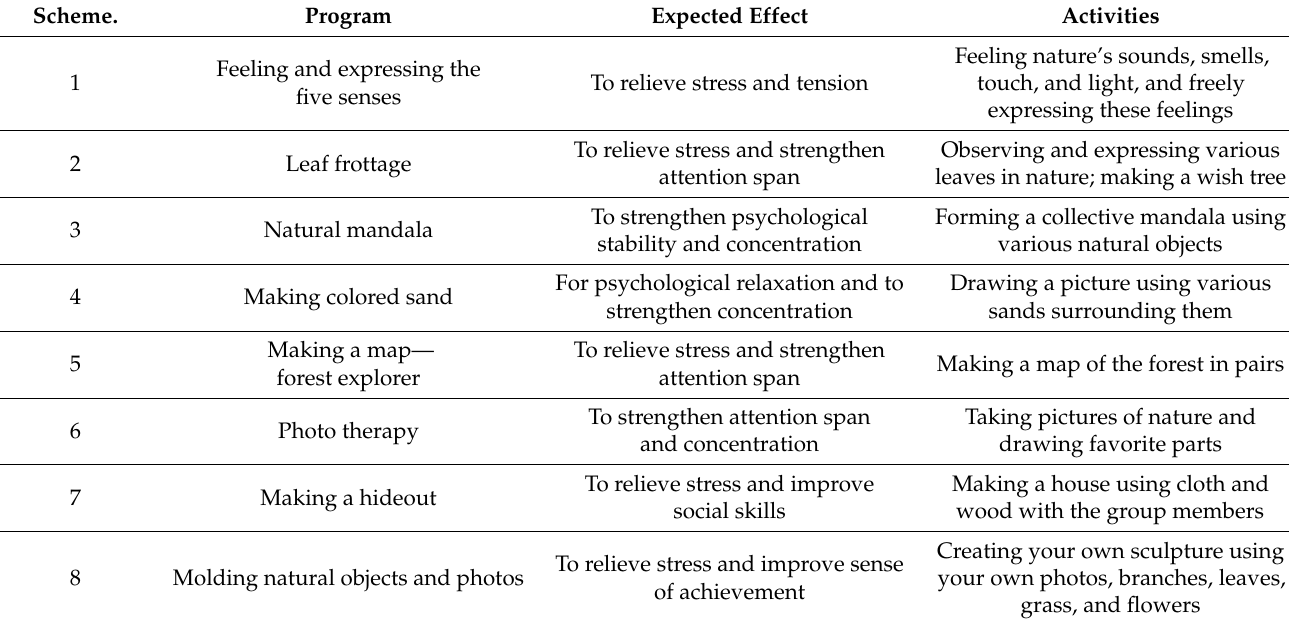
Table 1. Group art therapy